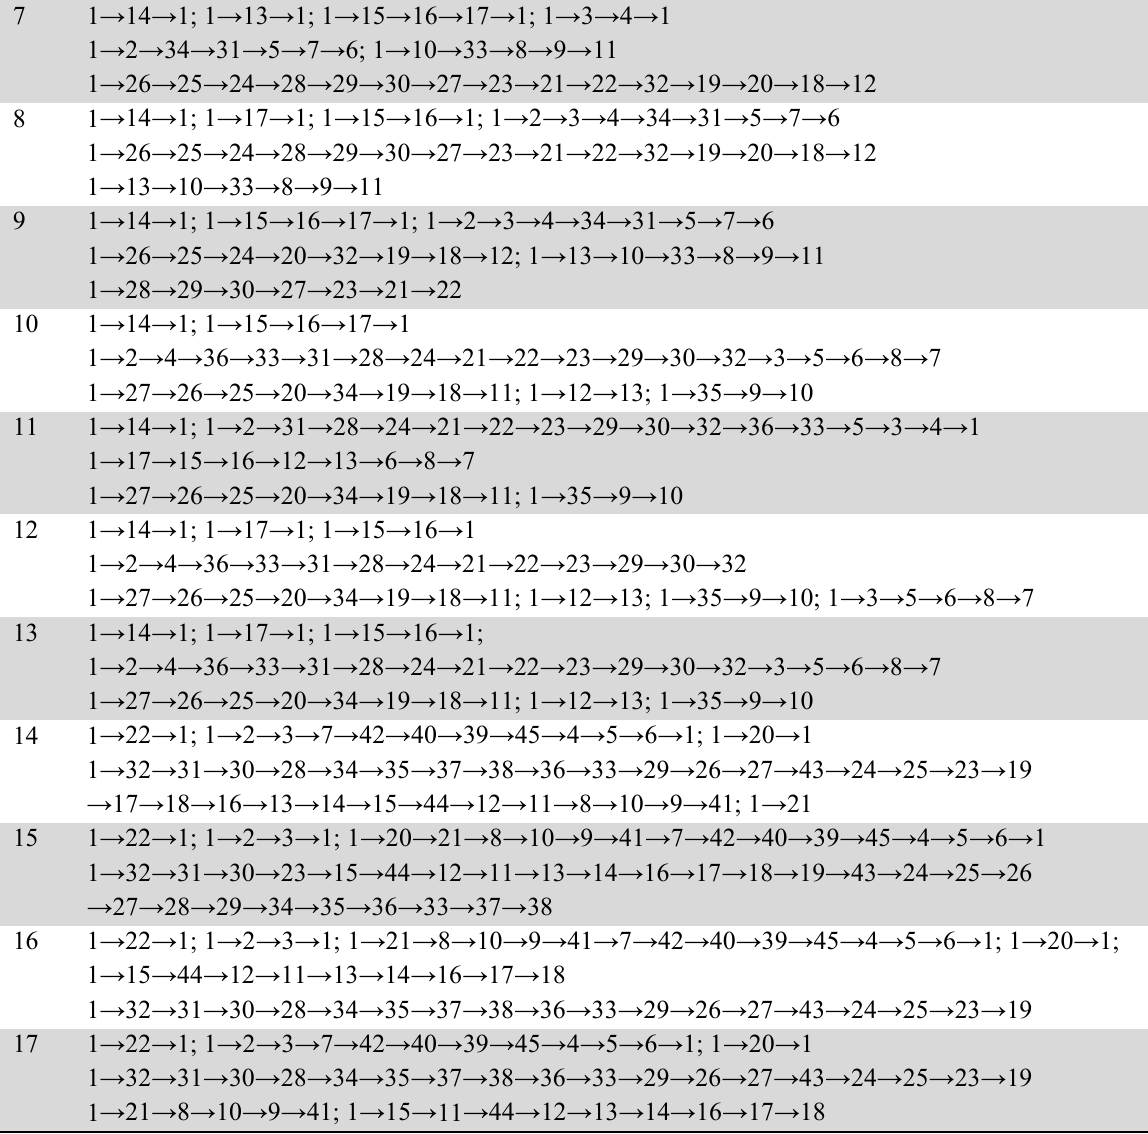
Descriptive statistics of CPU runtime of LSA on random instances SN